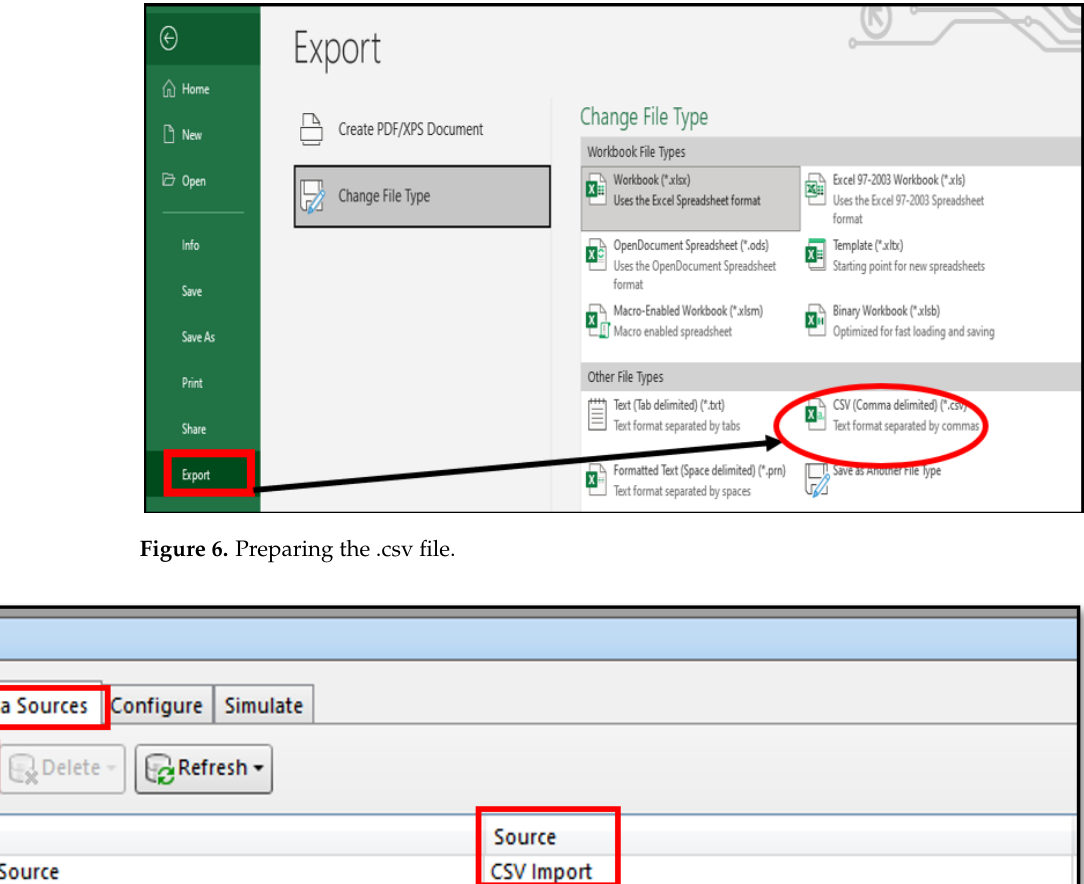
Figure 7. Importing the .csv file to the Navisworks software.